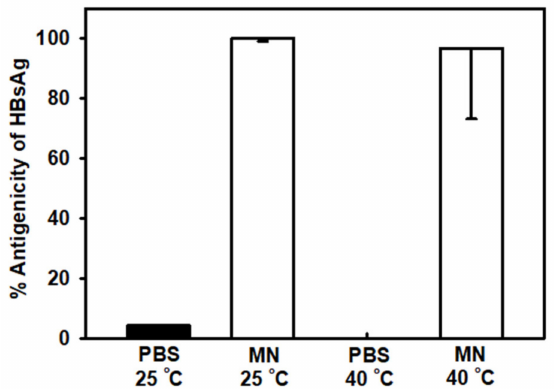
Figure 5. Comparison of HBsAg antigenicity in phosphate bu ff ered saline (PBS) and on microneedles (MNs) at 25 ◦ C and 40 ◦ C after 2 months of storage. Data represented as average ± SD ( n =